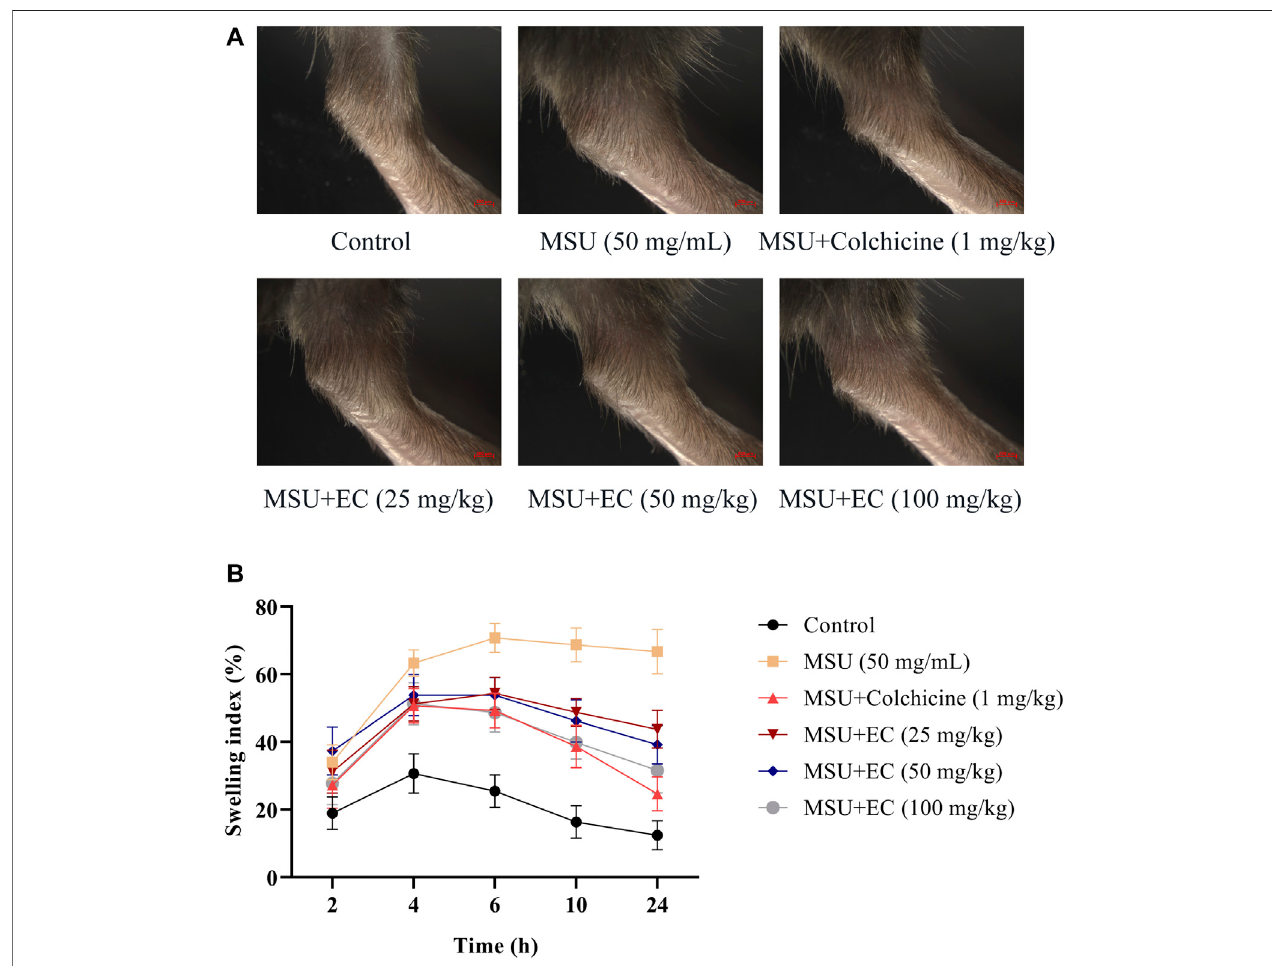
FIGURE 4 | Effect of EC on ankle joint swelling in C57BL/6 mice with MSU-induced acute gouty arthritis. Mice were intragastrically administrated with different doses of EC consecutively for 7 days, followed by MSU (0.025 ml MSU suspension with 50 mg/ml) injection into the ankle 1 h after EC administration on the sixth day. The swelling degree at different times is represented as the ratio of after injection to before injection. (A) Representative photo of ankle joint swelling in mice 24 h after MSU injection. (B) The tendency of swelling degree. Data are represented as mean ± SEM of ten mice per group. ** p < 0.01 compared with the control group; # p < 0.05 or ## p < 0.01 compared with the MSU group.